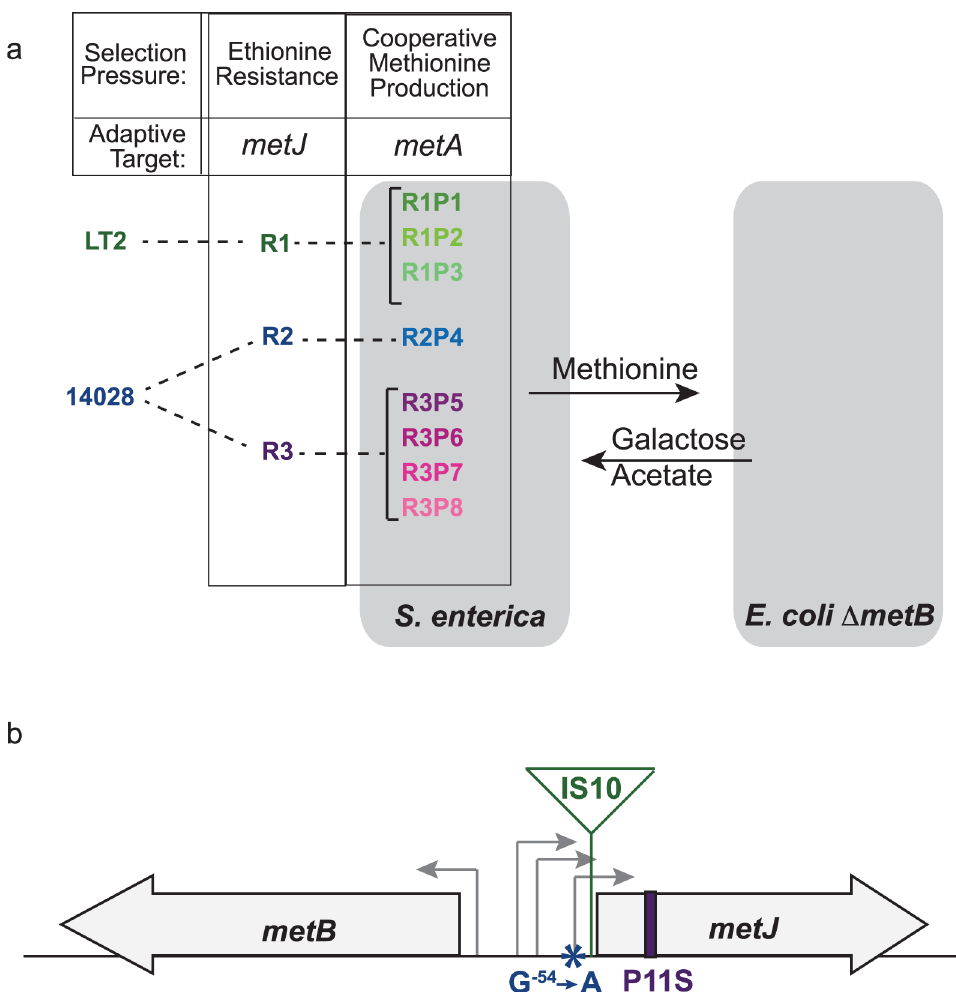
Fig 2. S . enterica producers evolved from ethionine-resistant strains that feature mutations in metJ . a) S . enterica ethionineresistant strains (R strains) were evolvedfrom wild-typeLT2 and 14028sstrains, and then co-cultured with E . coli methionine auxotrophson lactose minimalmedia. Adaptive methionine excretionby evolvedcooperators enabledgrowth of E . coli Δ metB . Sequencingrevealedparallelmutational targets in each strain during both selectionsteps: metJ duringselection for ethionine resistance(detailedin 1b) and metA duringselectionfor cooperative methionine production(detailedin [14]). b) A diagram of metJ shows the mutations in R1 (IS insertion), R2 (G -54 ➙ A mutation in promoter), and R3 (P11S residue substitution)that arose duringselectionfor resistanceto ethionine.